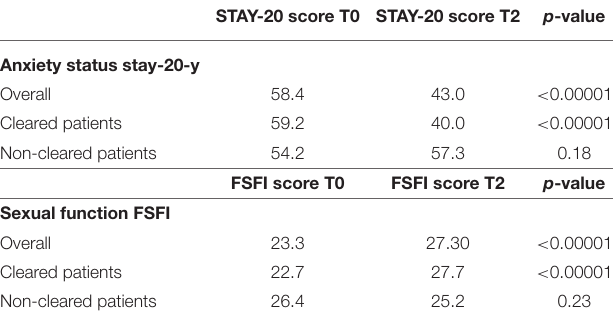
TABLE 3 | Psycho-sexual state. STAY-20 score T0 STAY-20 score T2 p -value Anxiety status